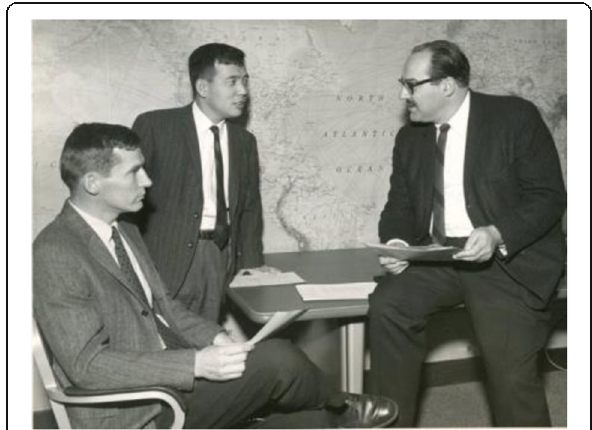
Fig. 15 Prof. Manabe, with Dr. Kirk Bryan (left) and the founder and former director of Geophysical Fluid Dynamics Laboratory, Joseph Smagorinksy (right). (Photo courtesy of the Geophysical Fluid Dynamics